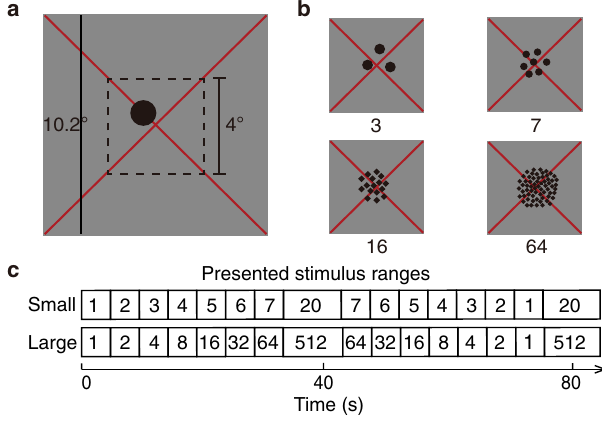
Fig. 5 Illustration of stimuli and experimental design. a A full example stimulus as seen by the participants in the scanner. The dot pattern covered the central 4° (visual angle) diameter within an 10.2° diameter mean- luminance (grey) fi eld. A large, thin, red fi xation cross passes diagonally through the centre of the display, and through the centre of the dot pattern. Participants fi xated at the intersection of the cross. b Example numerosity stimuli, where the total surface area of the dot pattern is constant across numerosities. c The sequence of the numerosity stimuli presented to the participants at the small and large ranges,